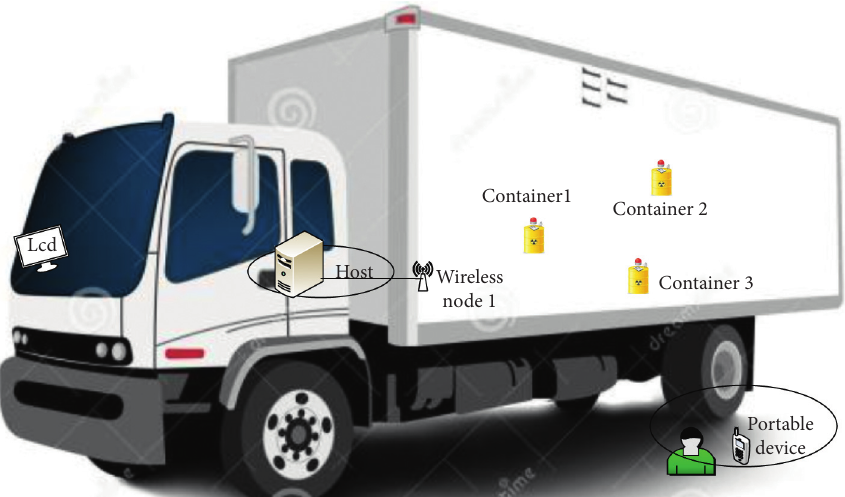
Figure 3: The single-vehicle transportation security system of radioactive